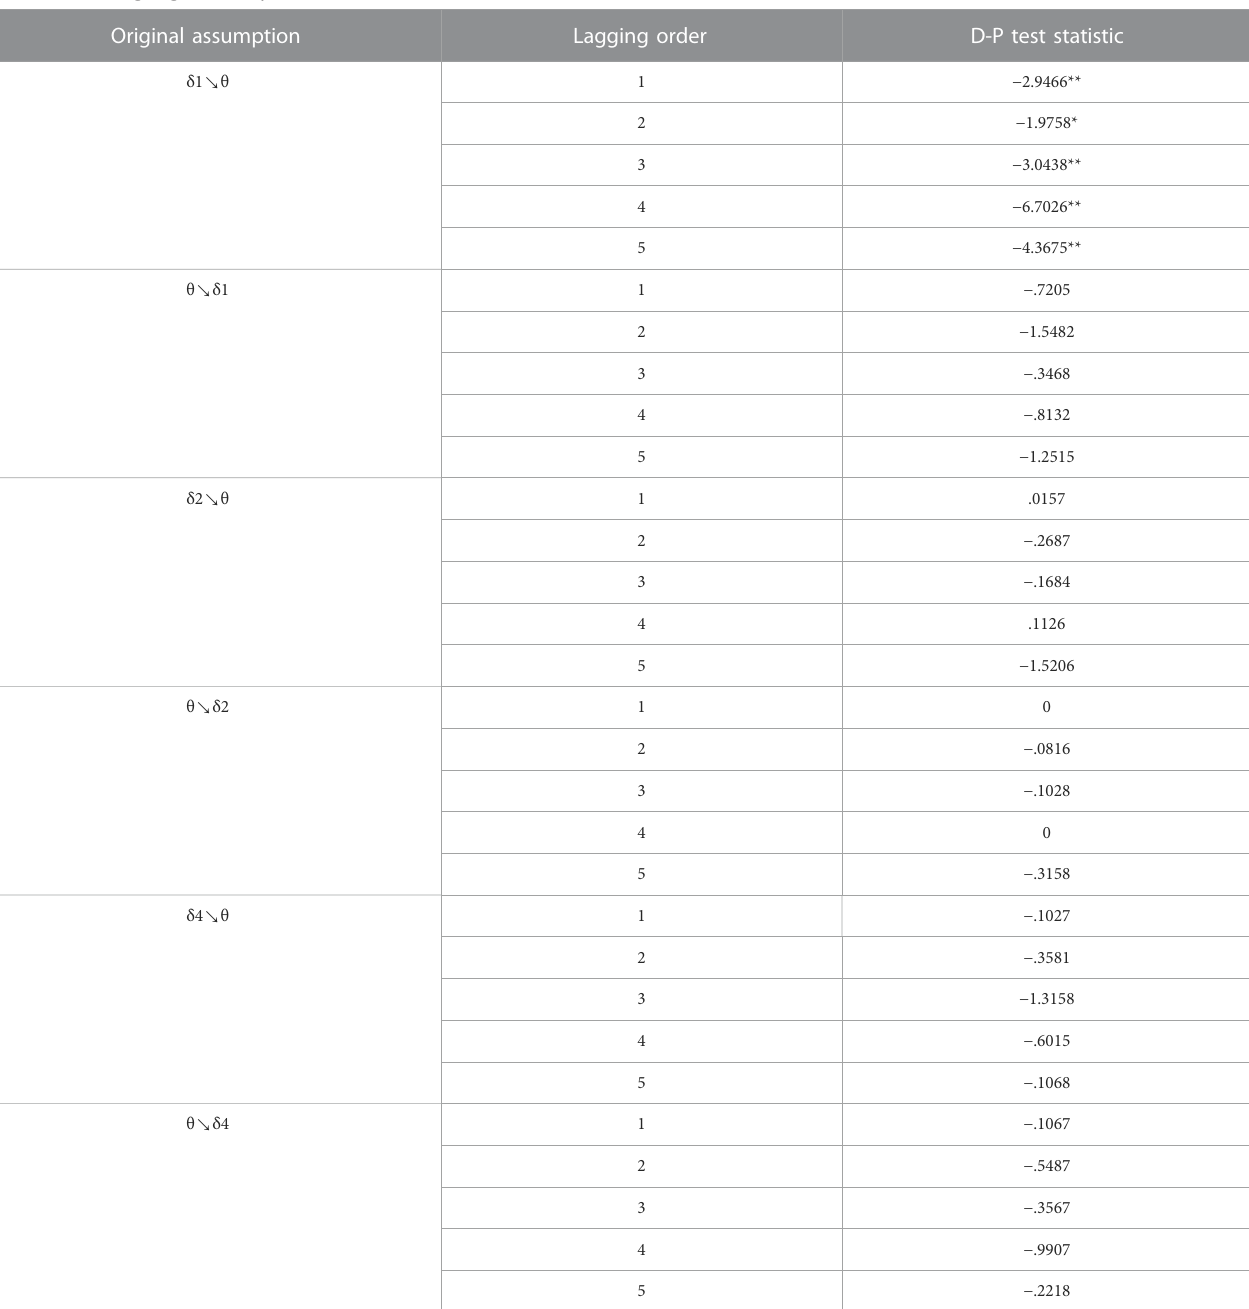
TABLE 4 Non-linear granger causality test